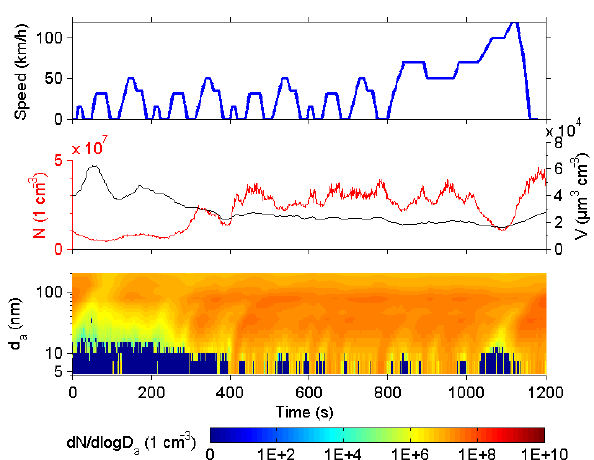
Figure 5. Speed profile, secondary particle number (measured by the CPC) and volume concentrations (measured by the HRLPI) and secondary particle number size distributions (HRLPI) for the stud- ied gasoline passenger car during the NEDC test